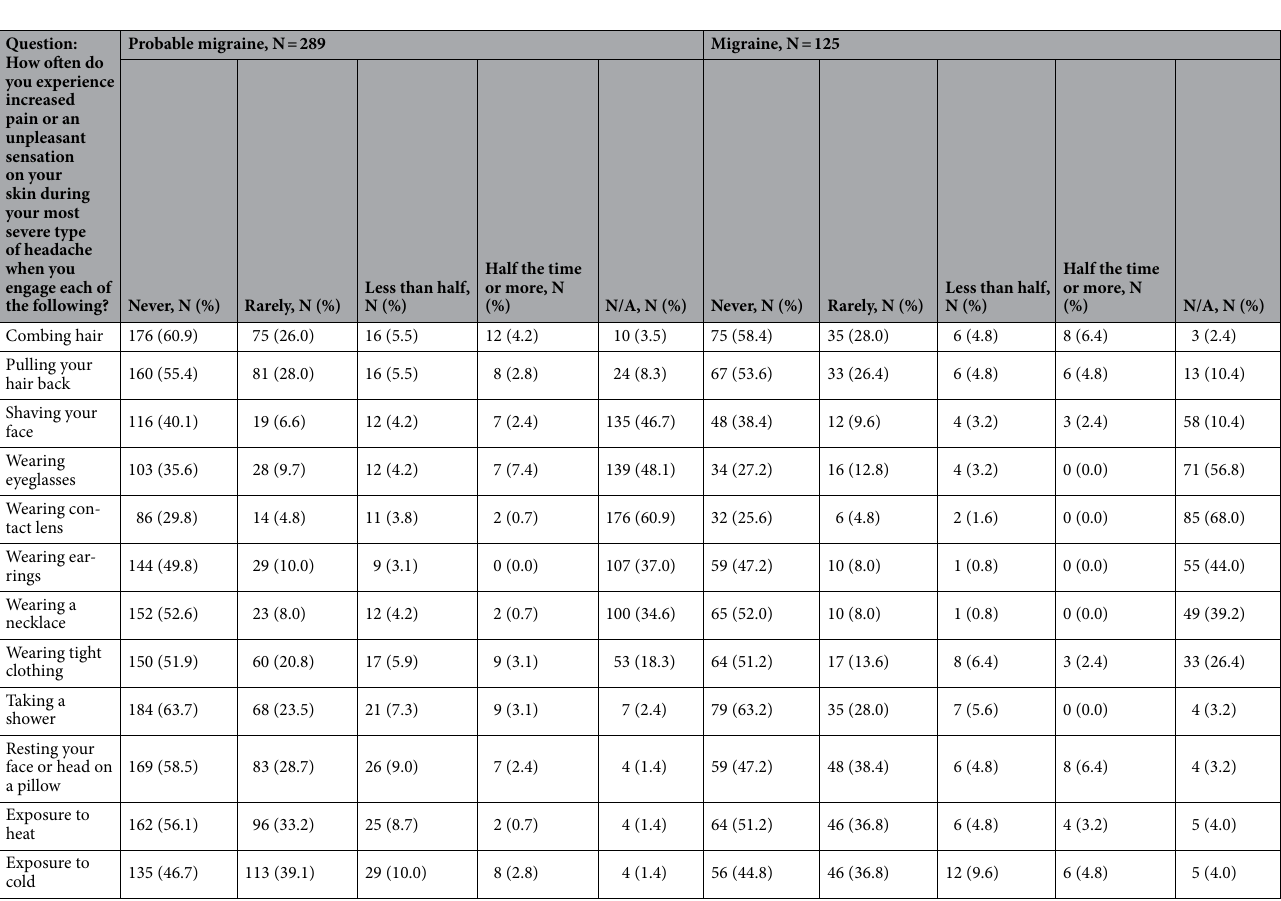
Table 2. Responses to the Allodynia Symptom Checklist-12 by individuals with probable migraine and migraine. ASC-12: Allodynia Symptom Checklist-12, N/A: not